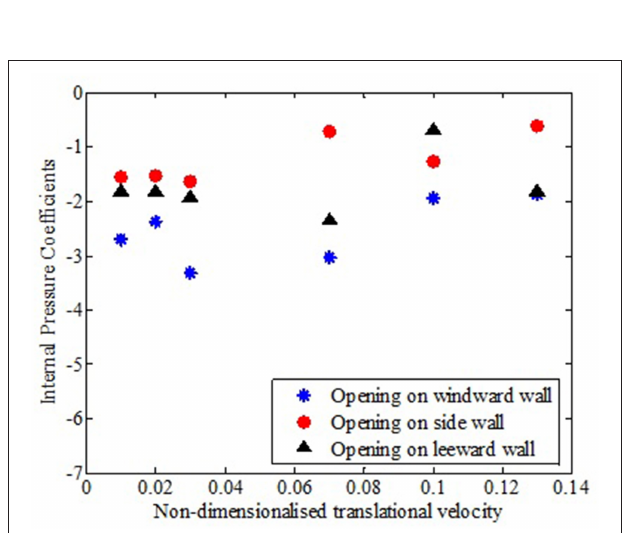
FIGURE 9 | External pressure co-efficients at different locations of windward wall to translating vortex and roof at various translational